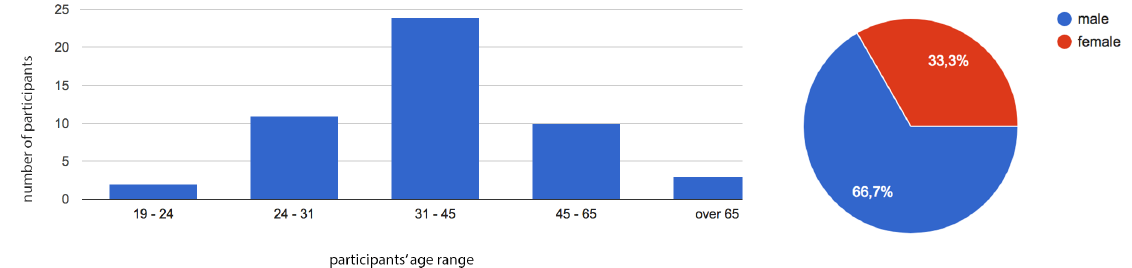
Figure 8. Demographics of the participants. Out a total number of 48, 66.7% was male and 33% was female. The prominent age span was between 31 and 45